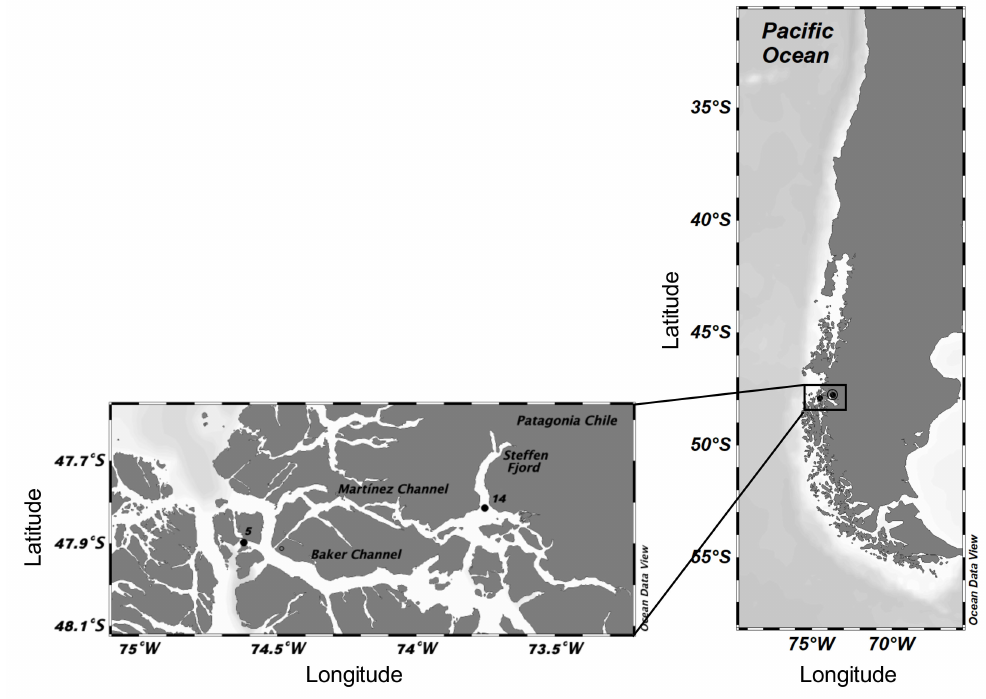
Figure 1. Map showing the location of the stations sampled (dots) in October 2014 in northern Chilean